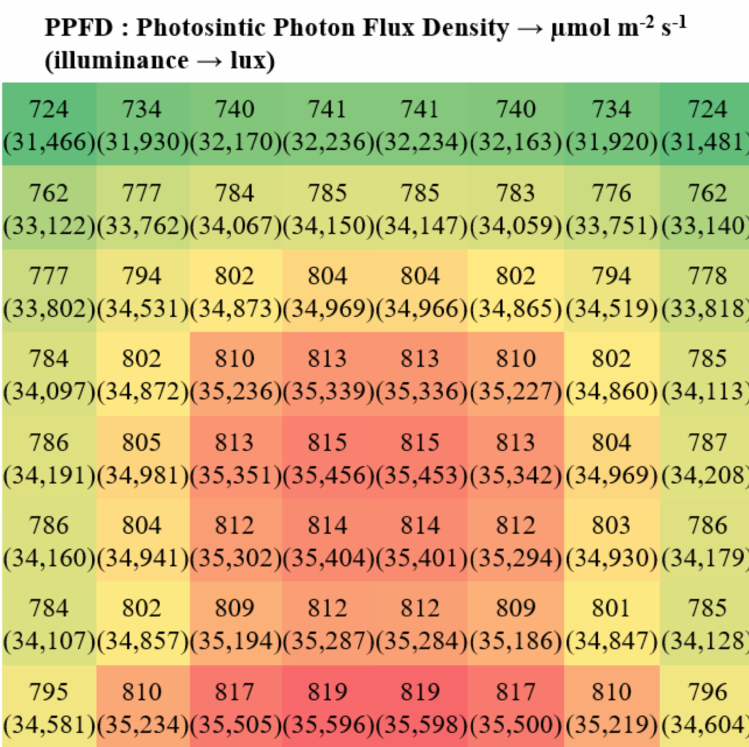
Figure 16. PPFD (illuminance) map of Case